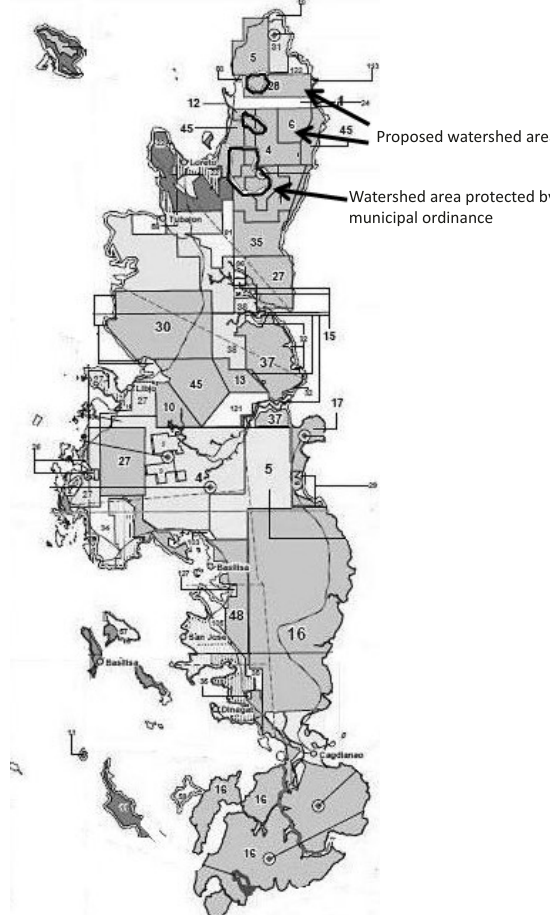
Figure 3. Map of mining claims, watershed area currently protected by municipal ordinance (total area of 8.676km 2 ) and two proposed protected watershed areas (according to Tenement control map of region XIII, 2011).